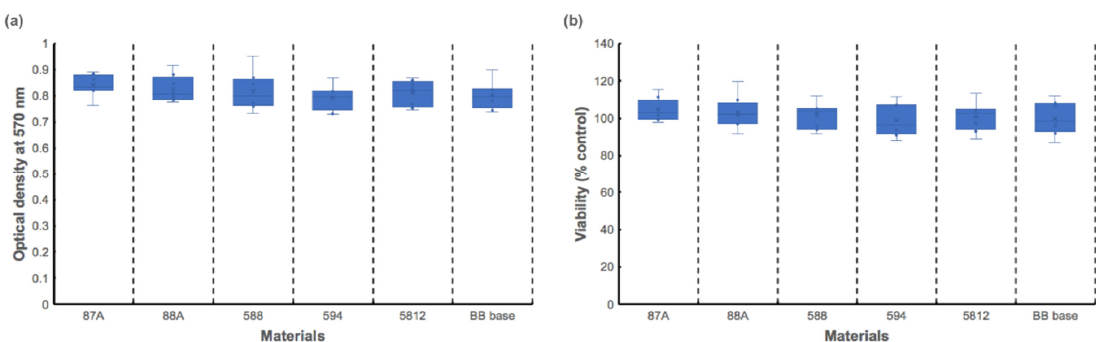
Figure 7. MTT assay results showing L929 cell viability after incubation in extracts from 5 UA-based photopolymer resins and a BB base. ( a ) optical density values, ( b ) viability.